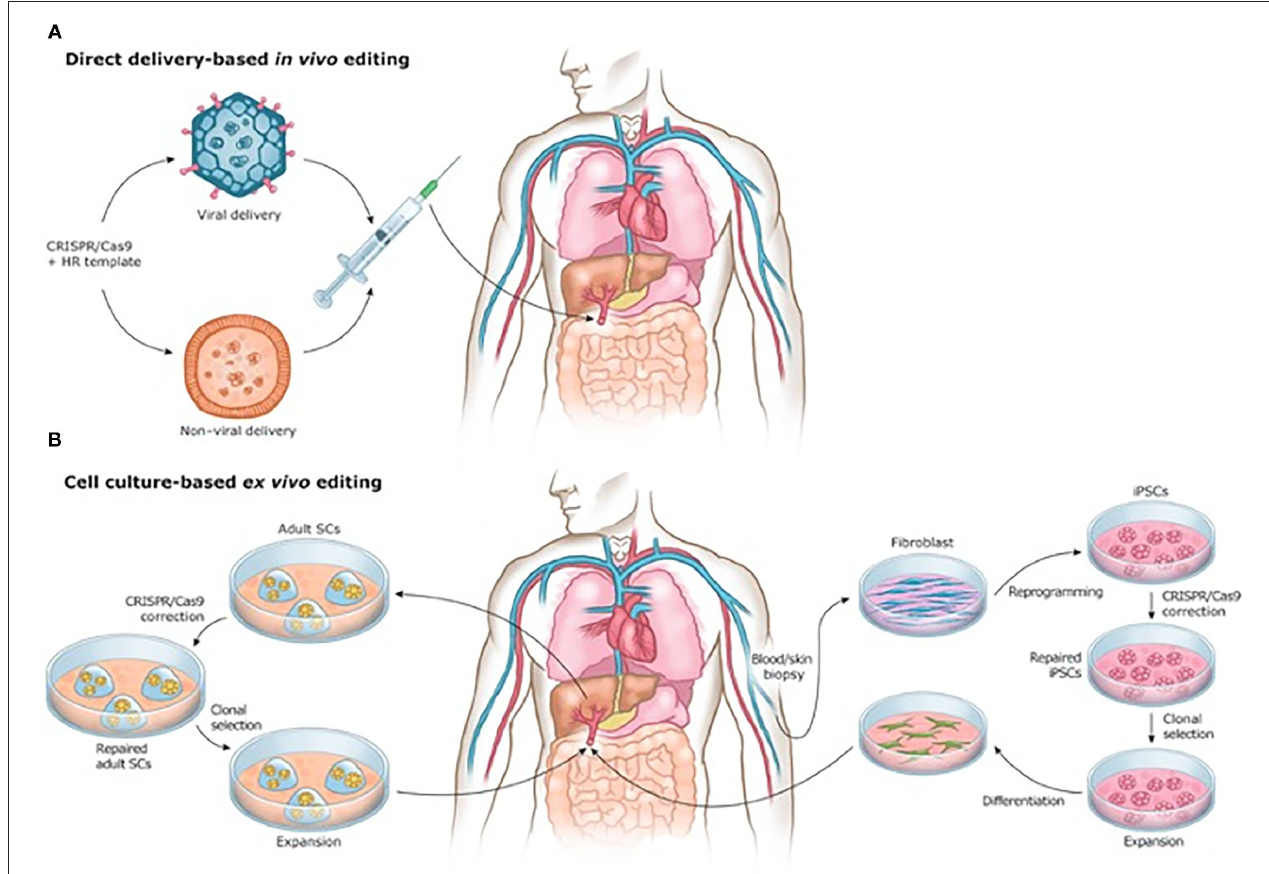
FIGURE 7 | (A) In vivo and (B) ex vivo strategies for CRISPR/Cas9-based gene therapies. Reprinted from Savi´c et al. (276).